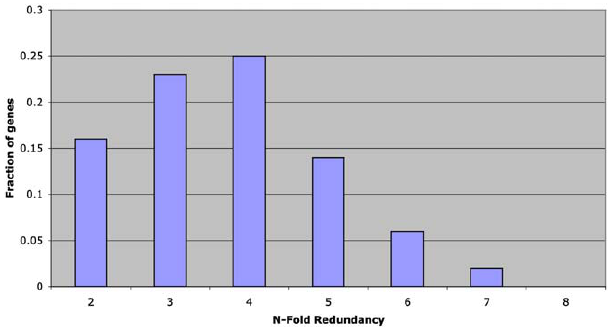
Figure 6. Histogram Showing the Lower Bound Estimate of N- fold Redundancy Using the Analysis Reported in Figure 5 This histogram is generated by counting the depth of paralogon redundancy across all human chromosomes as shown in the lower part of Figure S2 (and subsampled for Figure 5). The peak at 4-fold coverage is consistent with the 2R hypothesis, and constitutes a lower bound estimate, because the sliding window examines only a small span of flanking genes and would be highly subject to effects of local gene rearrangements. DOI: 10.1371/journal.pbio.0030314.g006